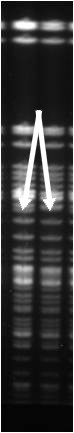
PFGE pattern with ApaI restriction enzyme showing different pulsotypes of environmental MRSA isolates spa-type t011. One band of difference (arrow), Right lane - pulsotype A. Left lane - pulsotype A1.